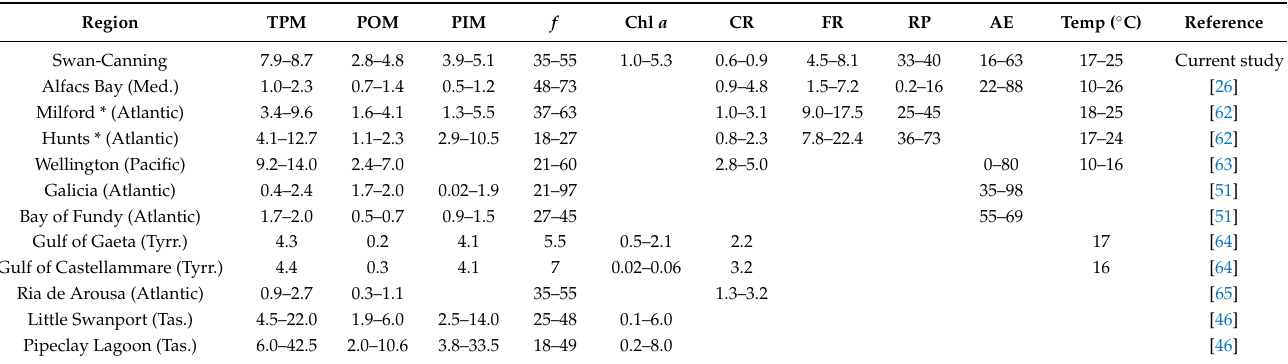
Table A1. Water seston and feeding parameters of Mytilus galloprovincialis in this and various previous studies; total particulate matter (TPM, mg L − 1 ), particulate organic matter (POM, mg L − 1 ), particulate inorganic matter (PIM, mg L − 1 ), seston quality ( f , %), chlorophyll a (Chl a , µ g L − 1 , clearance rate (CR, L h − 1 ), filtration rate (FR, mg h − 1 ), rejection proportion (RP, %), absorption efficiency (AE, %). Range in values presented for the current study represents means of values derived in summer and in